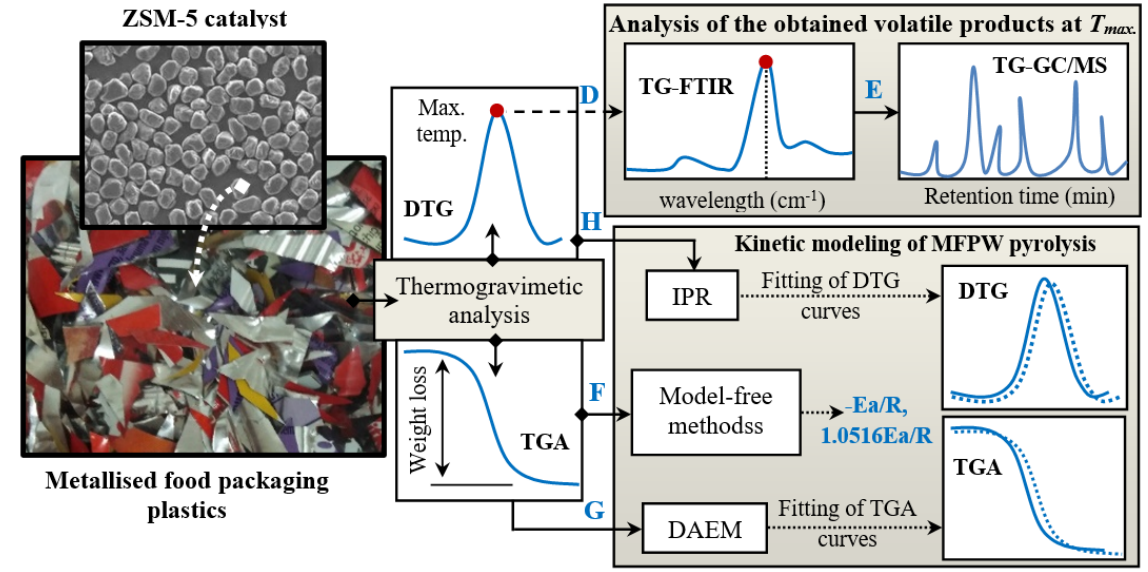
Figure 1. Flowchart of the experiments and analysis in the current work.